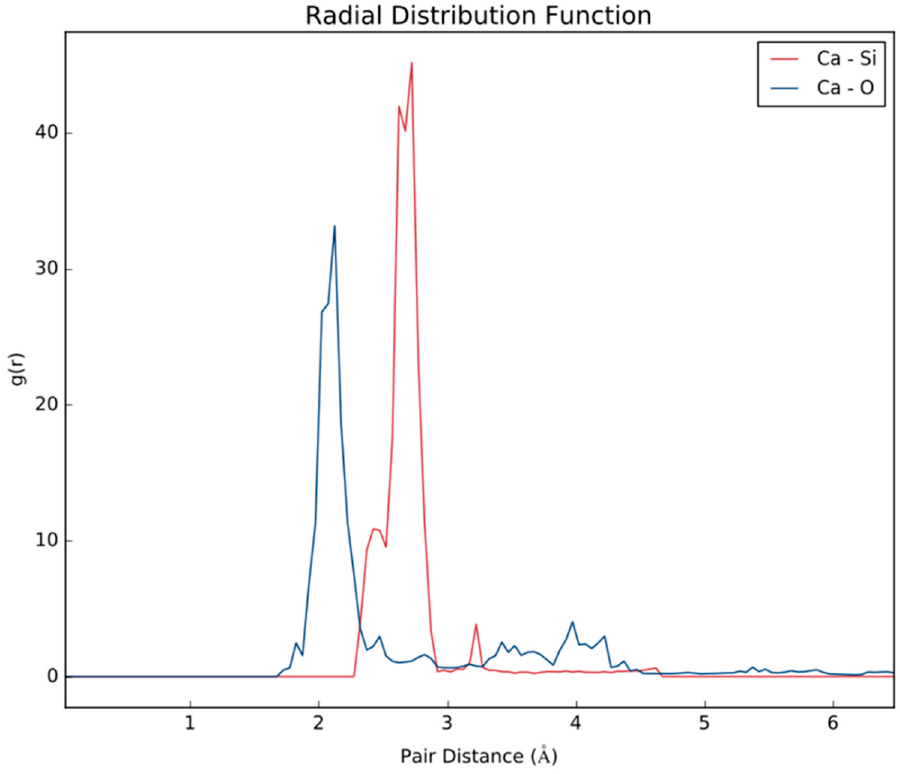
Figure 8. The radial distribution function of the MD trajectory of PAM ‐ Silica with Ca 2+ ions.